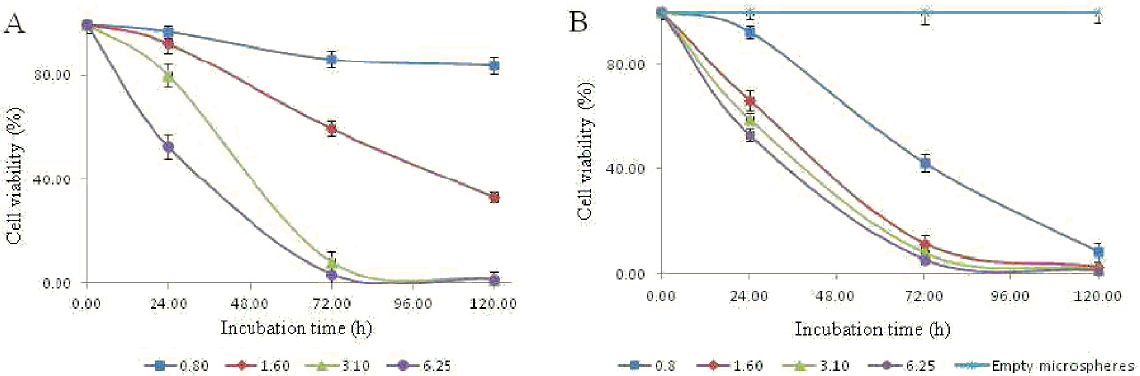
PLOS ONE | https://doi.org/10.1371/journal.pone.0181241 July 25,